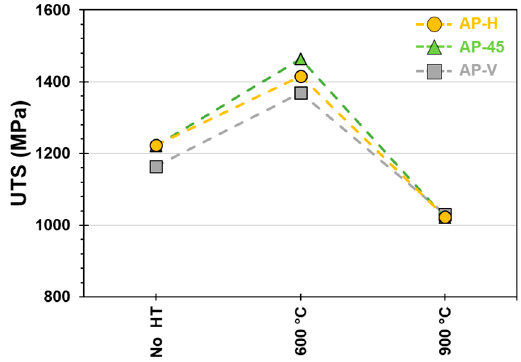
Figure 6. Changes in tensile strength due to heat ‐ treatment for all three print orientations.